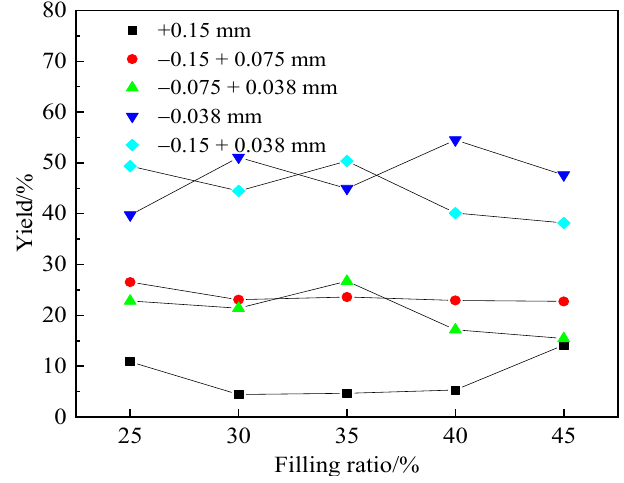
Figure 7. Particle size of grinding product at different filling ratios.